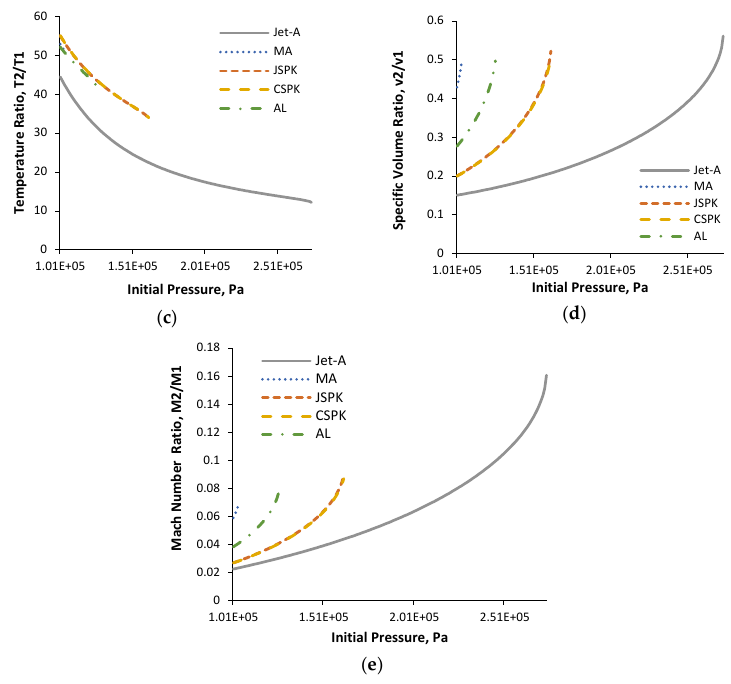
Figure 8. Comparison of ( a ) Mach number; ( b ) pressure ratios; ( c ) temperature ratios; ( d ) specific volume ratios; and ( e ) Mach number ratios at different initial pressure under influence of strong detonation (T = 2000 K, G = 6000 kg/s·m 2 ).